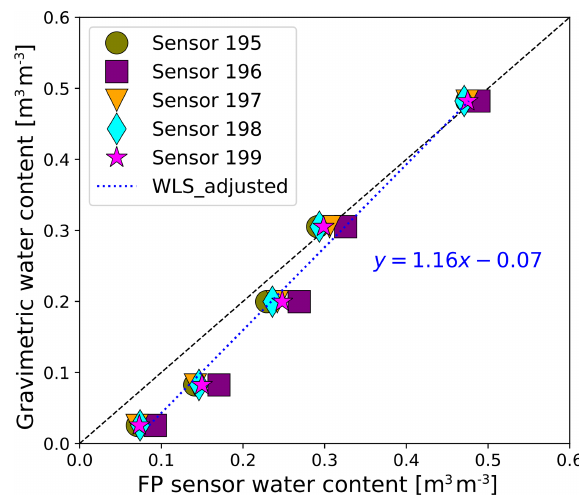
Figure 3. Sensor readings are plotted against gravimetric water con- tent under laboratory conditions. The fitted function, obtained by applying the weighted least squares (WLS) method, is displayed as a dotted line